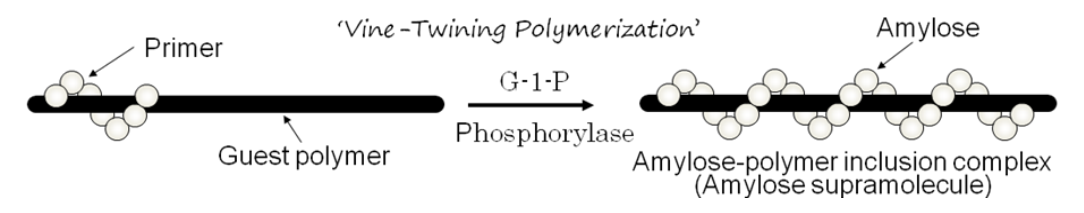
Figure 3. Image of ―vine-twining